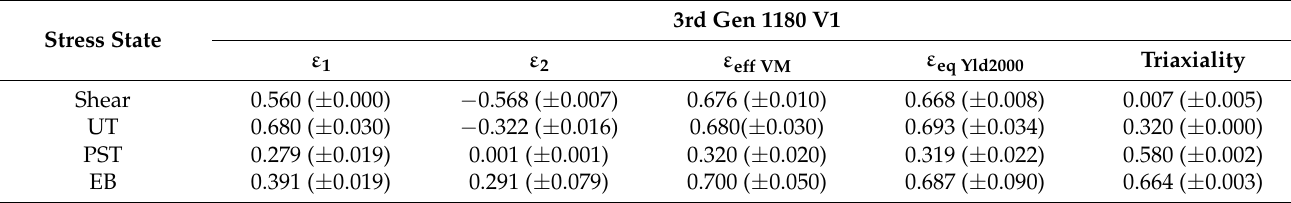
Table A7. Summary of fracture strains for the 3rd Gen 1180 V1 AHSS. Note that the von Mises effective strain corresponds to the absolute strain assuming a linear strain path. The Barlat Yld2000 equivalent strain corresponds to the accumulated work-conjugate equivalent strain integrated along the measured strain path and accounts for material